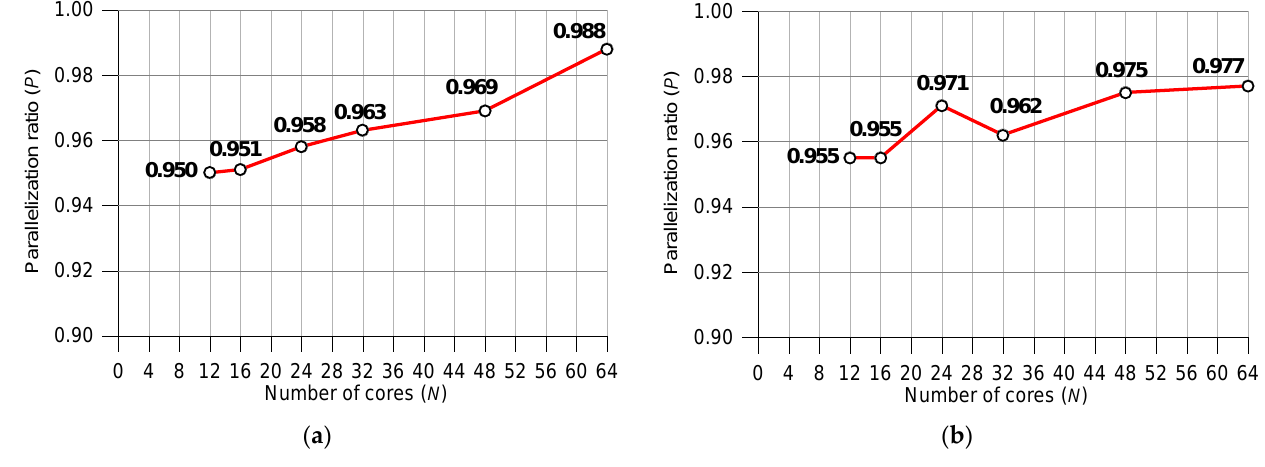
Figure 10. Parallelization ratio P achieved by the OpenMP+CAF version using dual-CPU computer systems: ( a ) Shallow foundation example; ( b ) Deep foundation example.